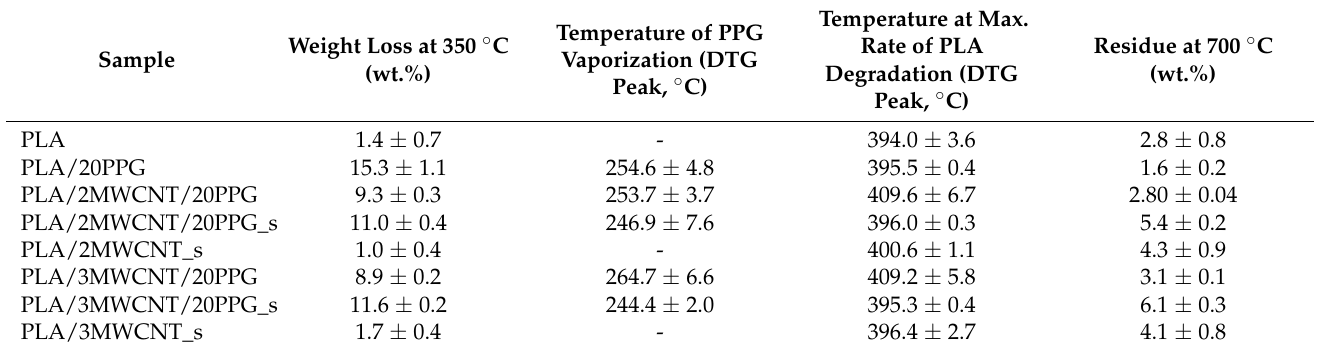
Figure 6. Thermal degradation of neat PLA and composites under N 2 atmosphere. Thermogravimetric analysis curves are displayed in the top row and the corresponding derivatives in the bottom row. Table 4. Thermogravimetric analysis results for PLA, PLA with PPG, and its MWCNT